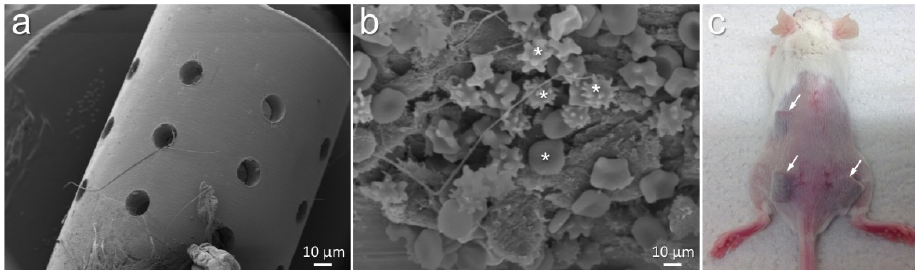
Figure 1. Morphology of titanium cylinders designed for implantation into mice ( a ). Implants allowed accumulation of various host cells visible after 21 days of implantation (( b ), white asterisks). Mouse showing the impression of subcutaneously implanted titanium cylinders (( c ), white arrows indicate implanted titanium).